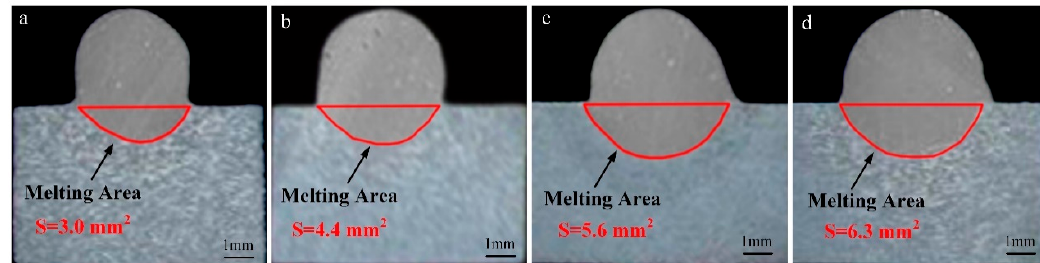
Figure 14. Weld shape and melting area of base metal when I VPPA-EN is varied and I MIG-EN is maintained at 70 A, for I VPPA-EN of ( a ) 30 A, ( b ) 40 A, ( c ) 50 A, and ( d ) 60 A.